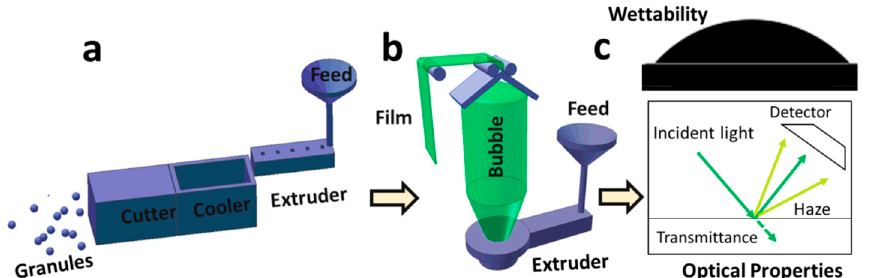
Figure 1. Schematic illustration of the preparation of large-scale polyethylene (PE) and ionomer ethylene/methacrylic acid (EMAA) copolymer films with tunable surface properties: ( a ) preparation of PE/EMAA granules for film blowing; ( b ) film blowing apparatus; ( c ) macroscopic performances, including surface wettability and optical properties.